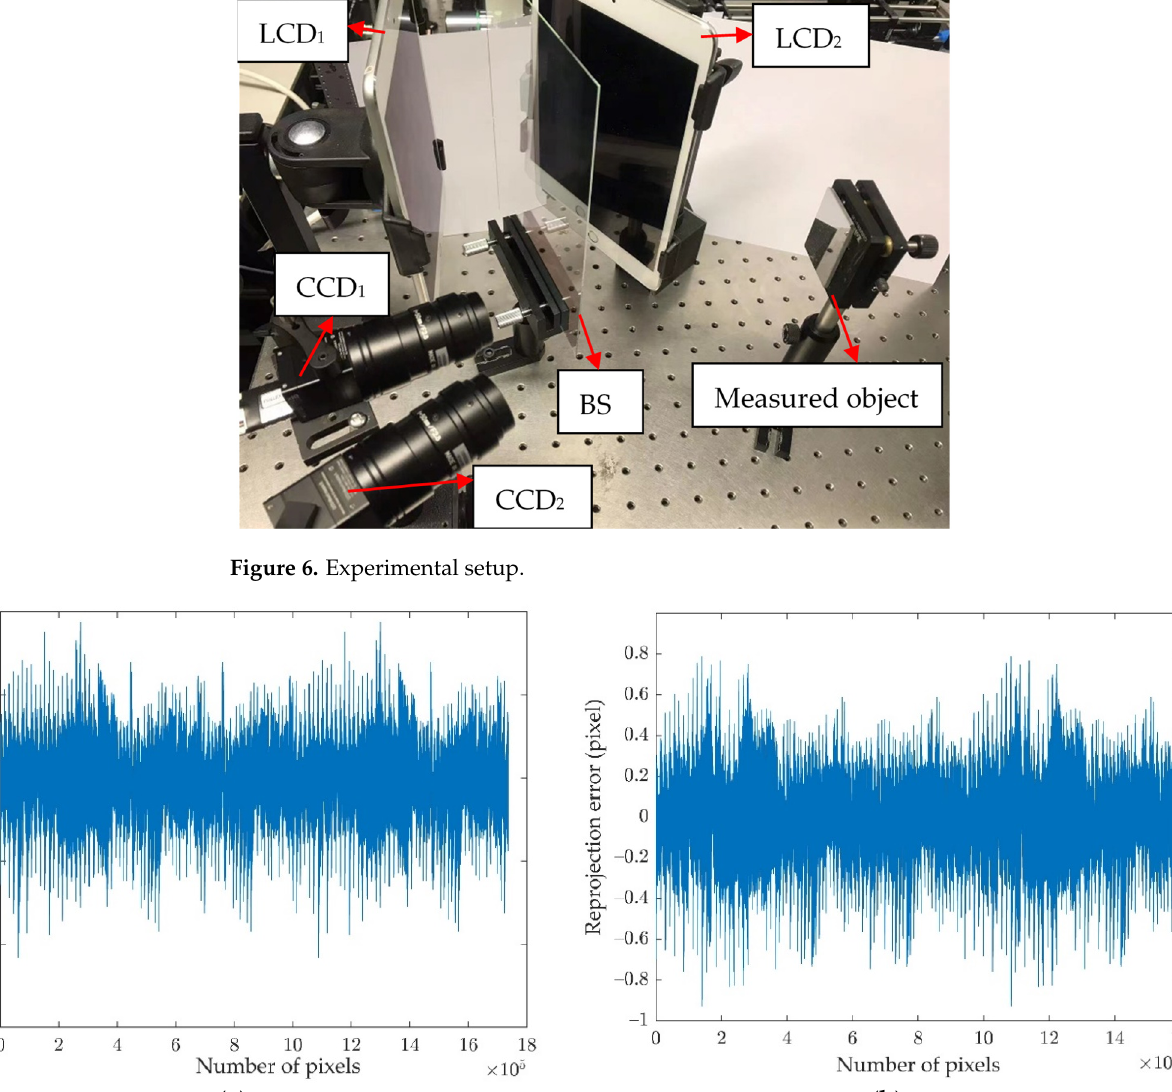
Figure 7. Reprojection error: ( a ) the reprojection error between LCD 1 and two cameras; ( b ) the reprojection error between LCD 2 ′ and two cameras.